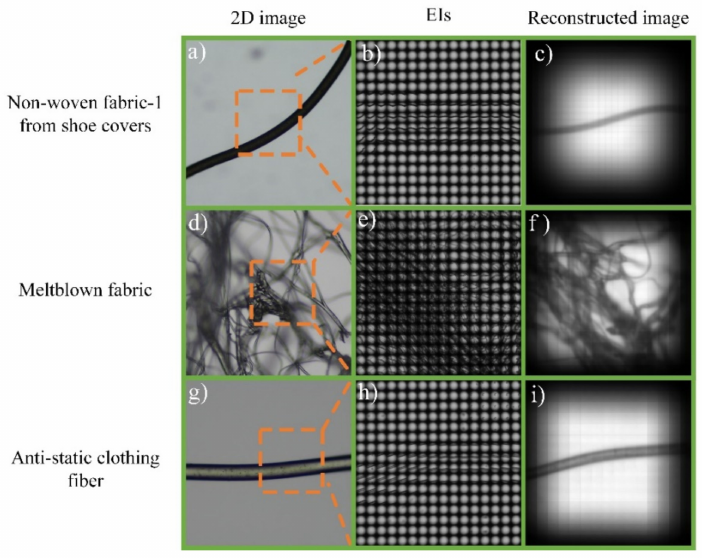
Figure 8. 2D images ( a , d , g ), elemental images (EIs) ( b , e , h ) and reconstructed image ( c , f , i ) of three different targets on the second sample in the experimental